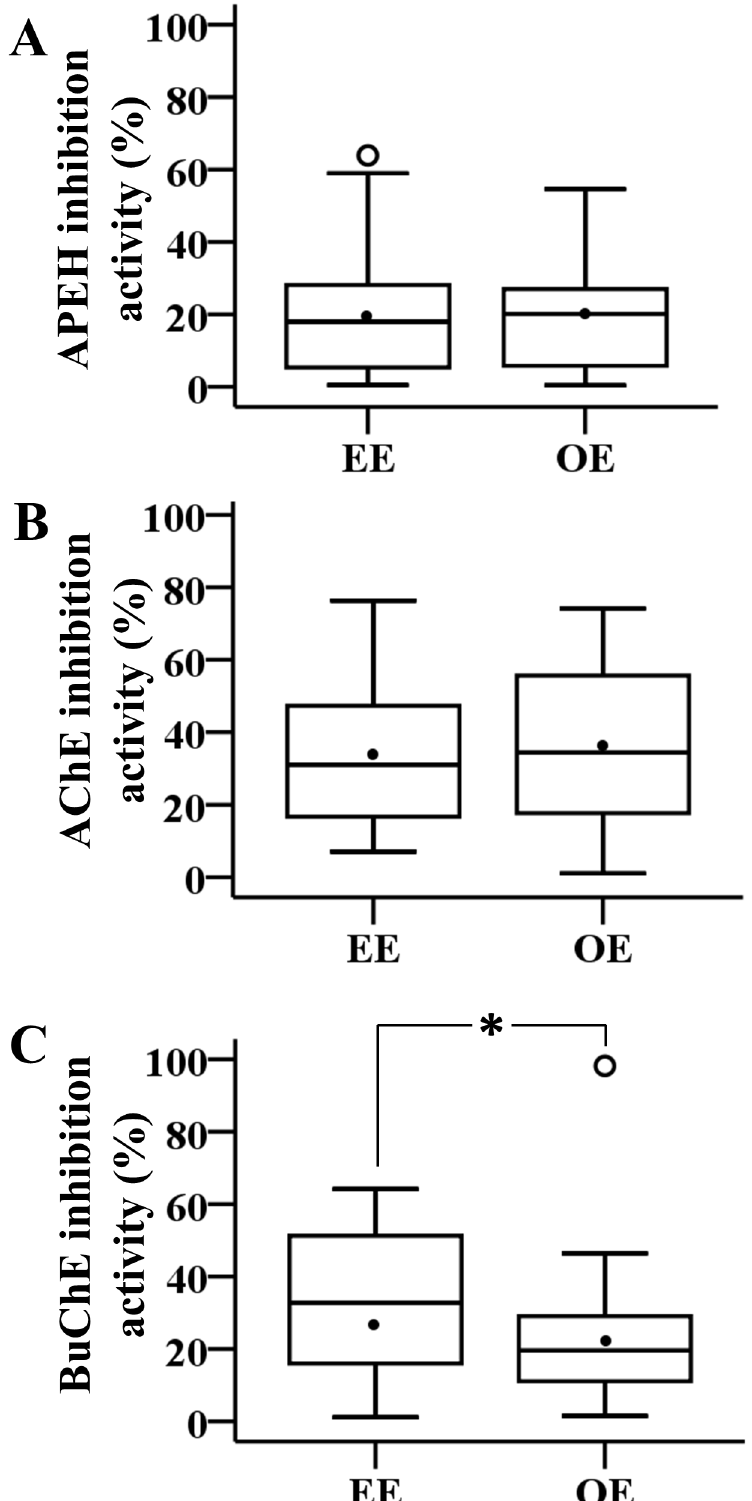
Fig 4. Magnitude of enzyme inhibition during the spray season. The box plots were made considering only those individuals showing enzyme inhibition during fumigation. The panels depict the distribution of the percentages of